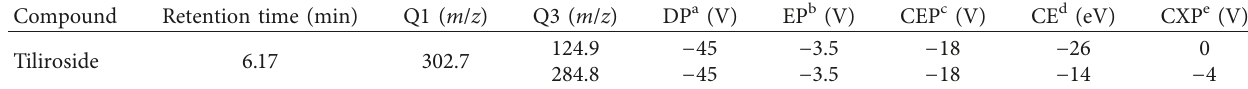
Table 2: Summary of optimized parameters for quantitative analysis of tiliroside.